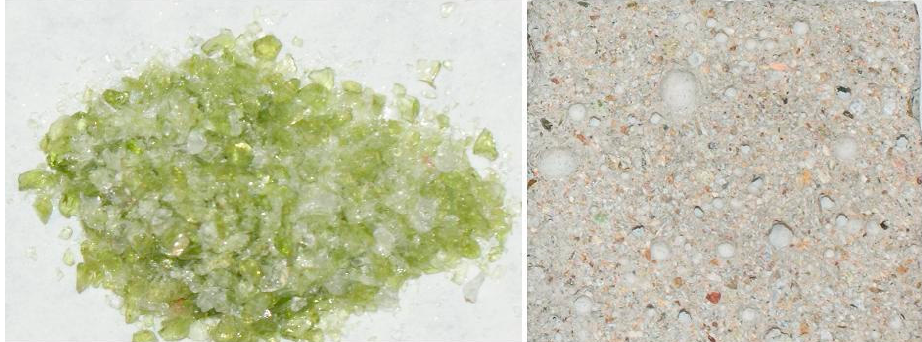
Figure 2. Crushed glass and mortar based on recycled glass as aggregate.